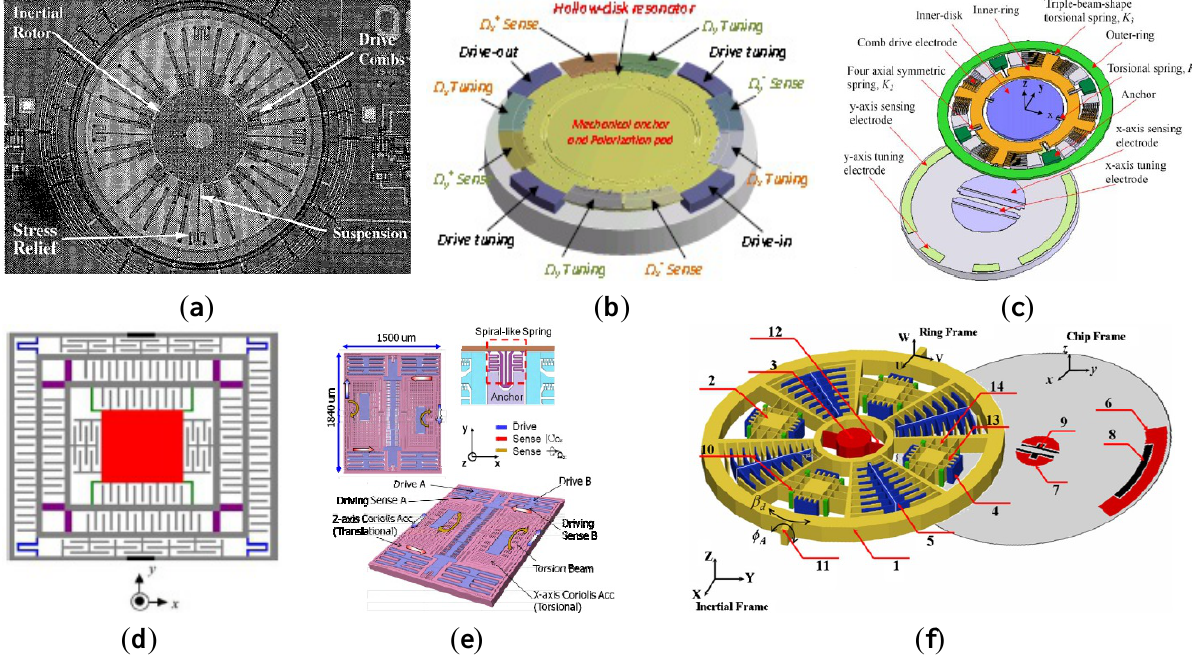
Figure 9. Various multi-axis gyroscopes. ( a ) UC Berkeley dual-axis gyroscope. ( b ) Georgia Tech dual-axis gyroscope. ( c ) National Tsing Hua University (NTHU) dual-axis gyroscope. ( d ) National Taiwan University (NTU) dual-axis gyroscope. ( e